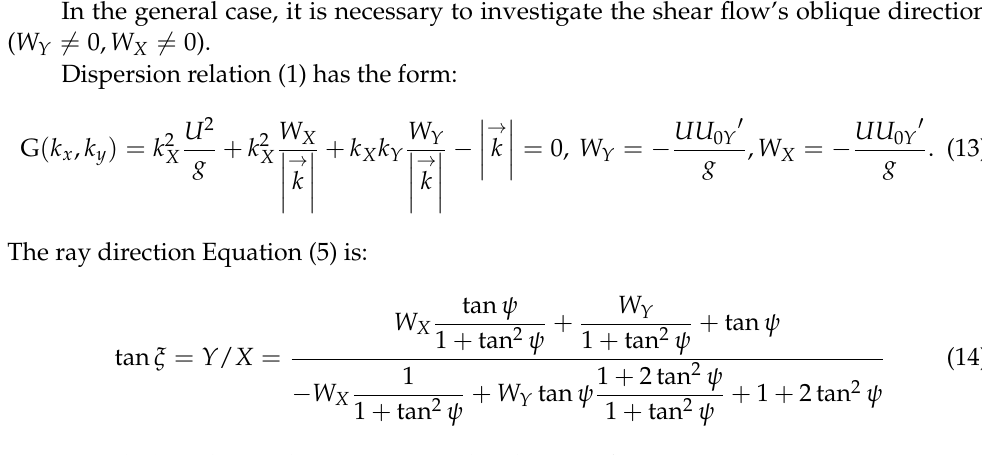
Figure 6. The angle of inclination of the cusp waves ψ m in depending on shear flow W Y .